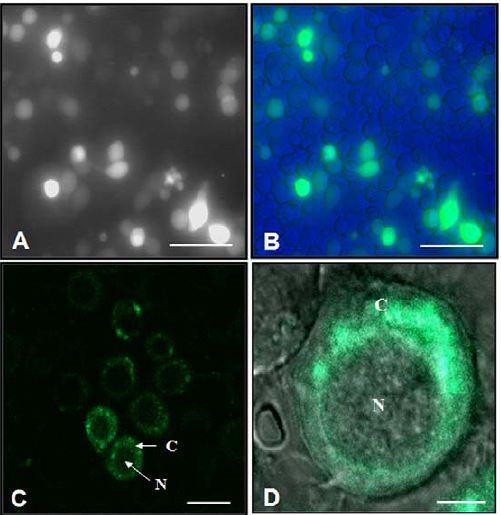
Figure 8. Sub-cellular localization of SLMG7 protein in the transfected Spli -221 cells. Spli -221 cells were transfected with pEGFP (A and B) and pEGFP/ Slmg 7 (C and D) plasmid DNAs, respectively. The GFP fragment was fused with Slmg 7 fragment at the C -terminal end. The photographs were taken through visible light (A) and fluorescence (B, C and D) filters at 48 h post transfection, respectively. D is an overlapped image under fluorescence and visible light filters. The bars represent 100 m m in (A) and (B), 40 m m in (C) and 10 m m in (D). N: nuclei; C: cytoplasm.